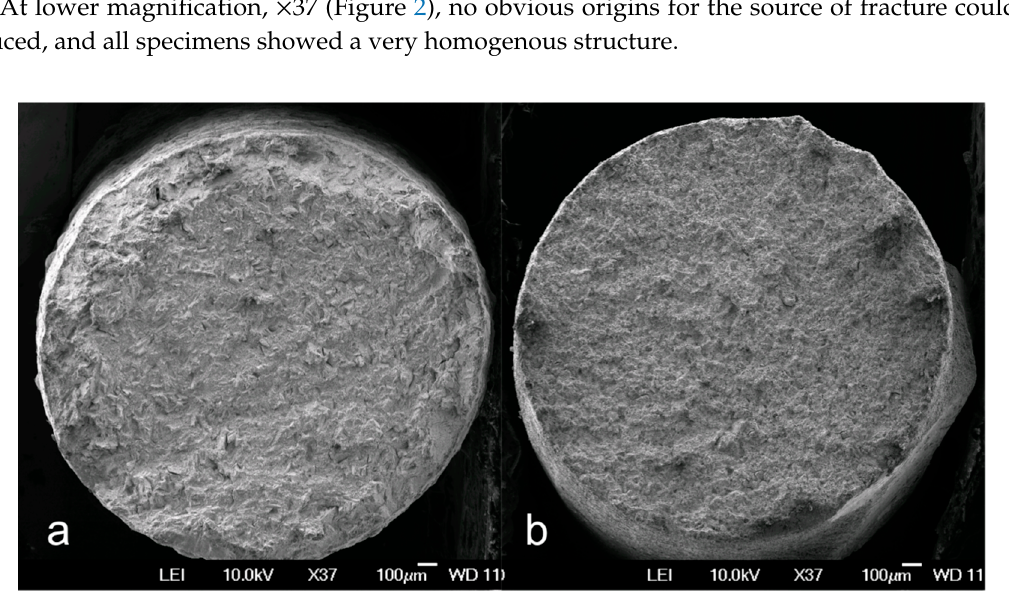
fracture surface of SM CoCr dumbbell. ( b )